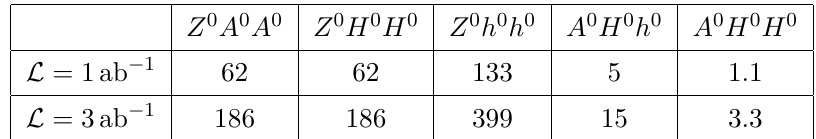
p s = 1 TeV, where